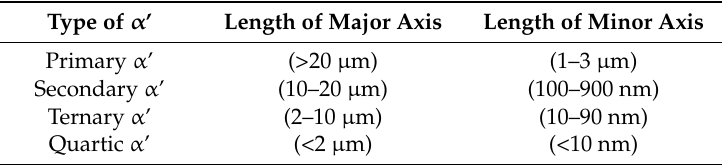
Figure 4. As-built microstructure: ( a ) BSD-SEM image revealing fine tertiary and quadric α ’ grains and sub-grain twinning (indicated with arrow); and ( b ) an enlarge image showing sub-grain twinning (indicated with arrows). Table 4. Hierarchical structure of α